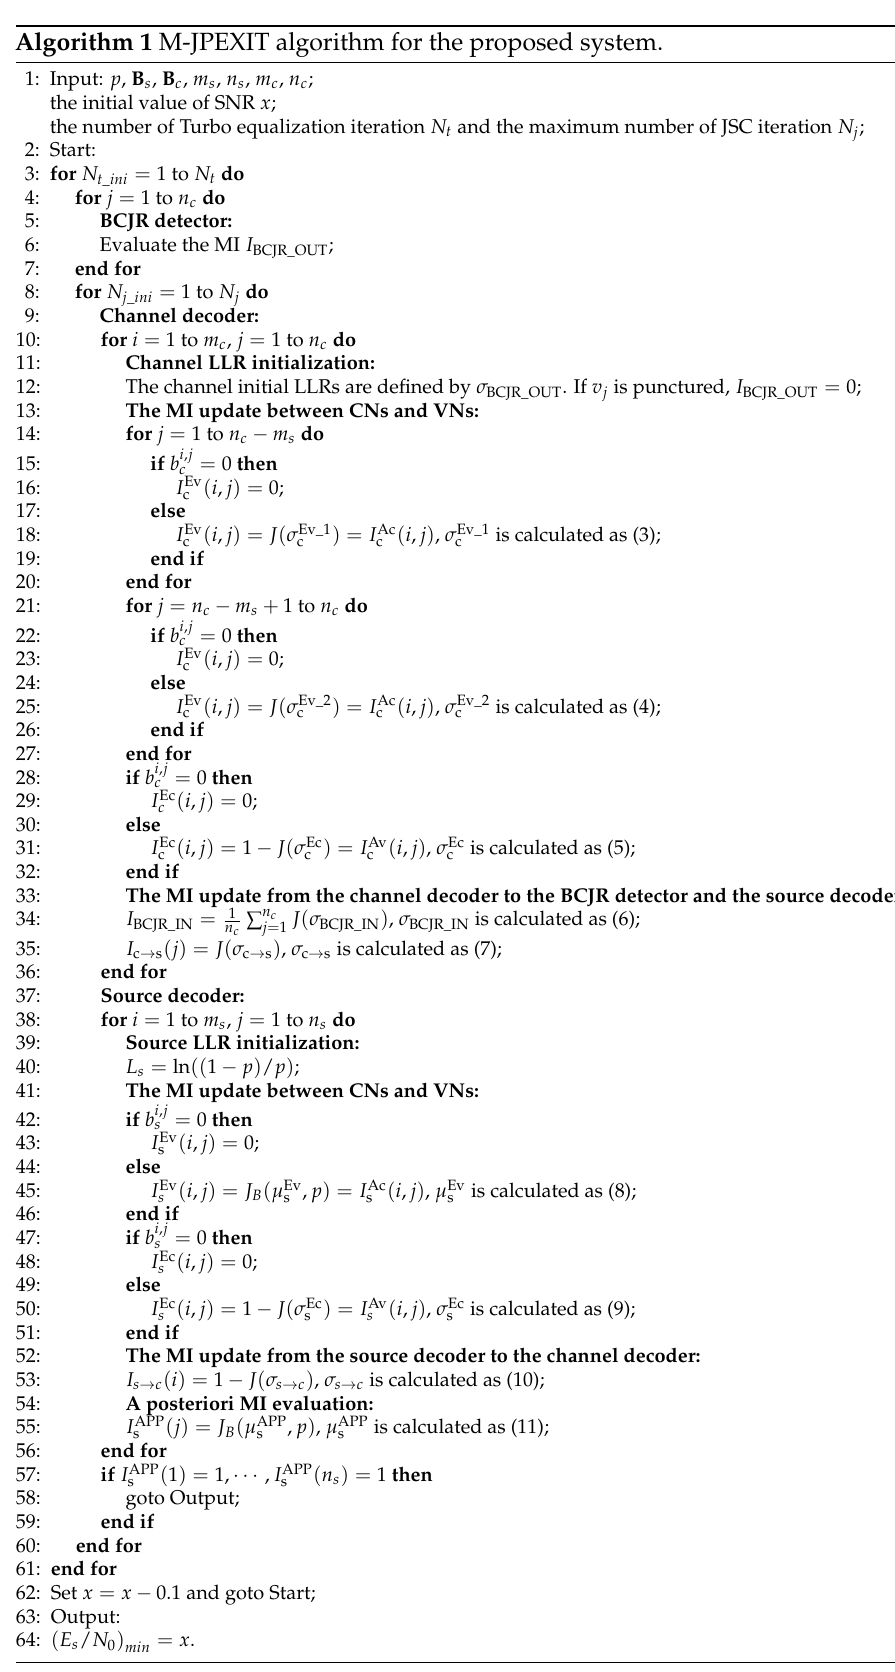
Algorithm 1 M-JPEXIT algorithm for the proposed